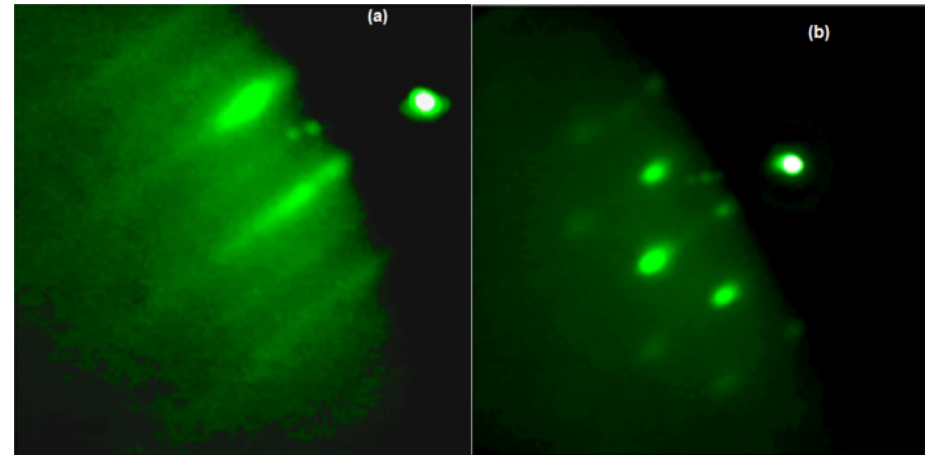
Figure 2. RHEED diffraction pattern. ( a ) During the growth of GaAs; ( b ) after the deposition of the InAs QDs.